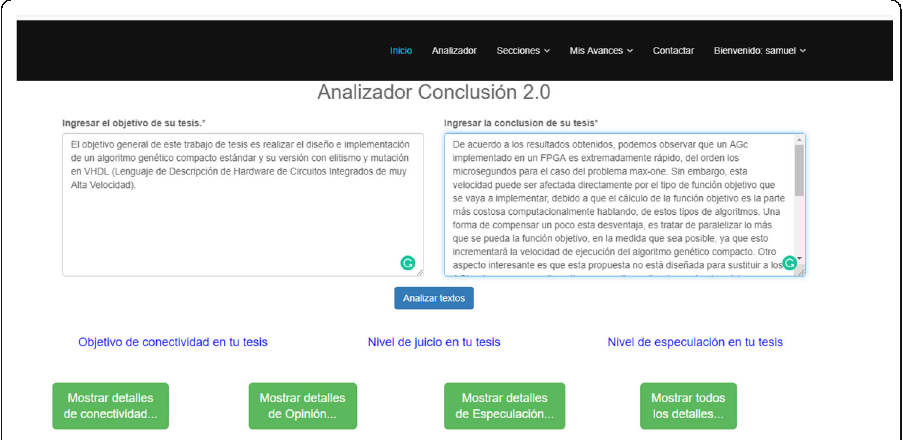
Fig. 2 System Interface of Analyzer (In